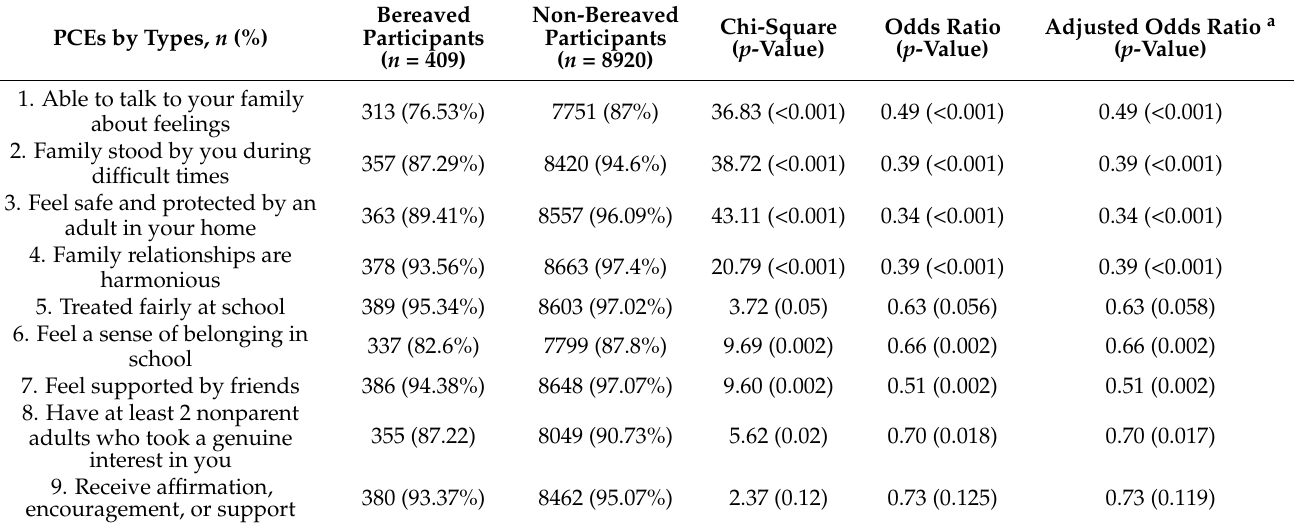
Table 3. PCEs types of exposure by adult self-reported childhood bereavement history.